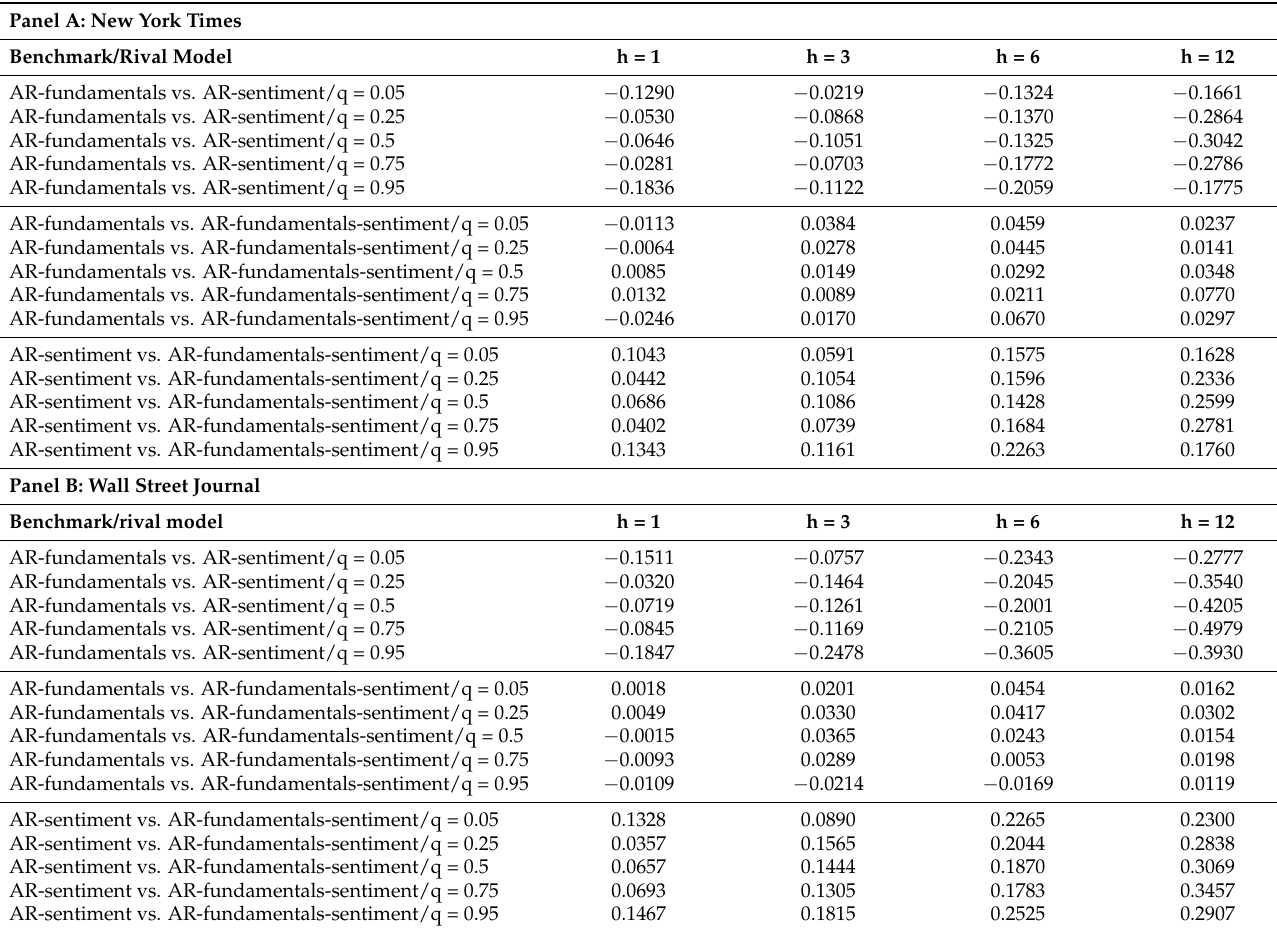
Table 2. Sentiment vs.